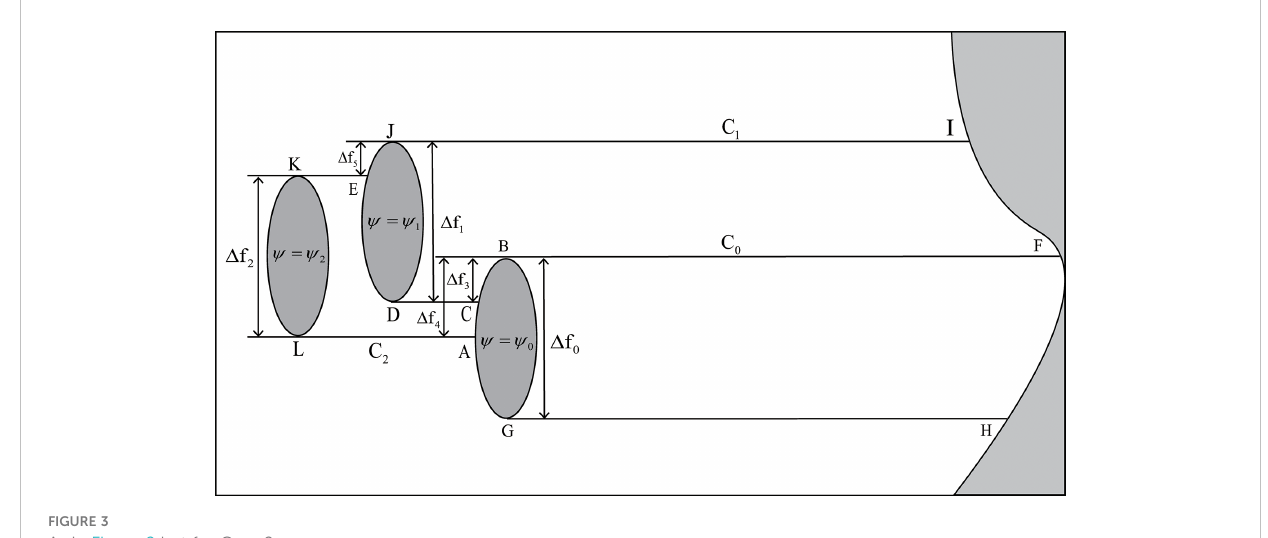
FIGURE 3 As in Figure 2 but for Case